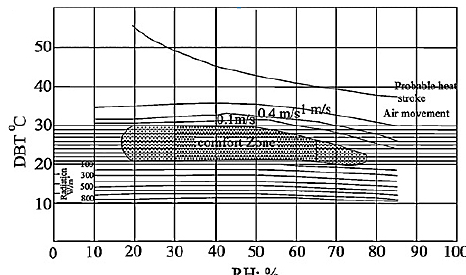
fig. 13. Bio-climatic comfort chart for tropical climates by olgyay showing upper and lower comfort limits Source: Koenigsberger et al.